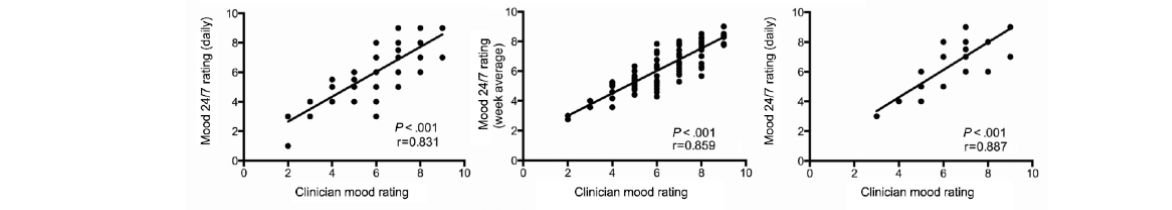
Figure 3. Long-term validation of Mood 24/7. Data from 9 patients collected over multiple office visits demonstrate lasting correlations between clinicians’ mood assessment and patients’ Mood 24/7 self-assessment rating. Positive correlations were found between the clinician mood rating and daily Mood 24/7 rating of 100 data points, with each point representing a unique patient and clinician assessment ( P <.001; left). Similarly, positive correlations were found between the clinician mood rating and the weekly average of Mood 24/7 rating of 100 data points ( P <.001; center); 44 data points collected from 1 patient over the course of 2 years demonstrated strong positive correlations between the clinician mood rating and Mood 24/7 rating ( P <.001; right).